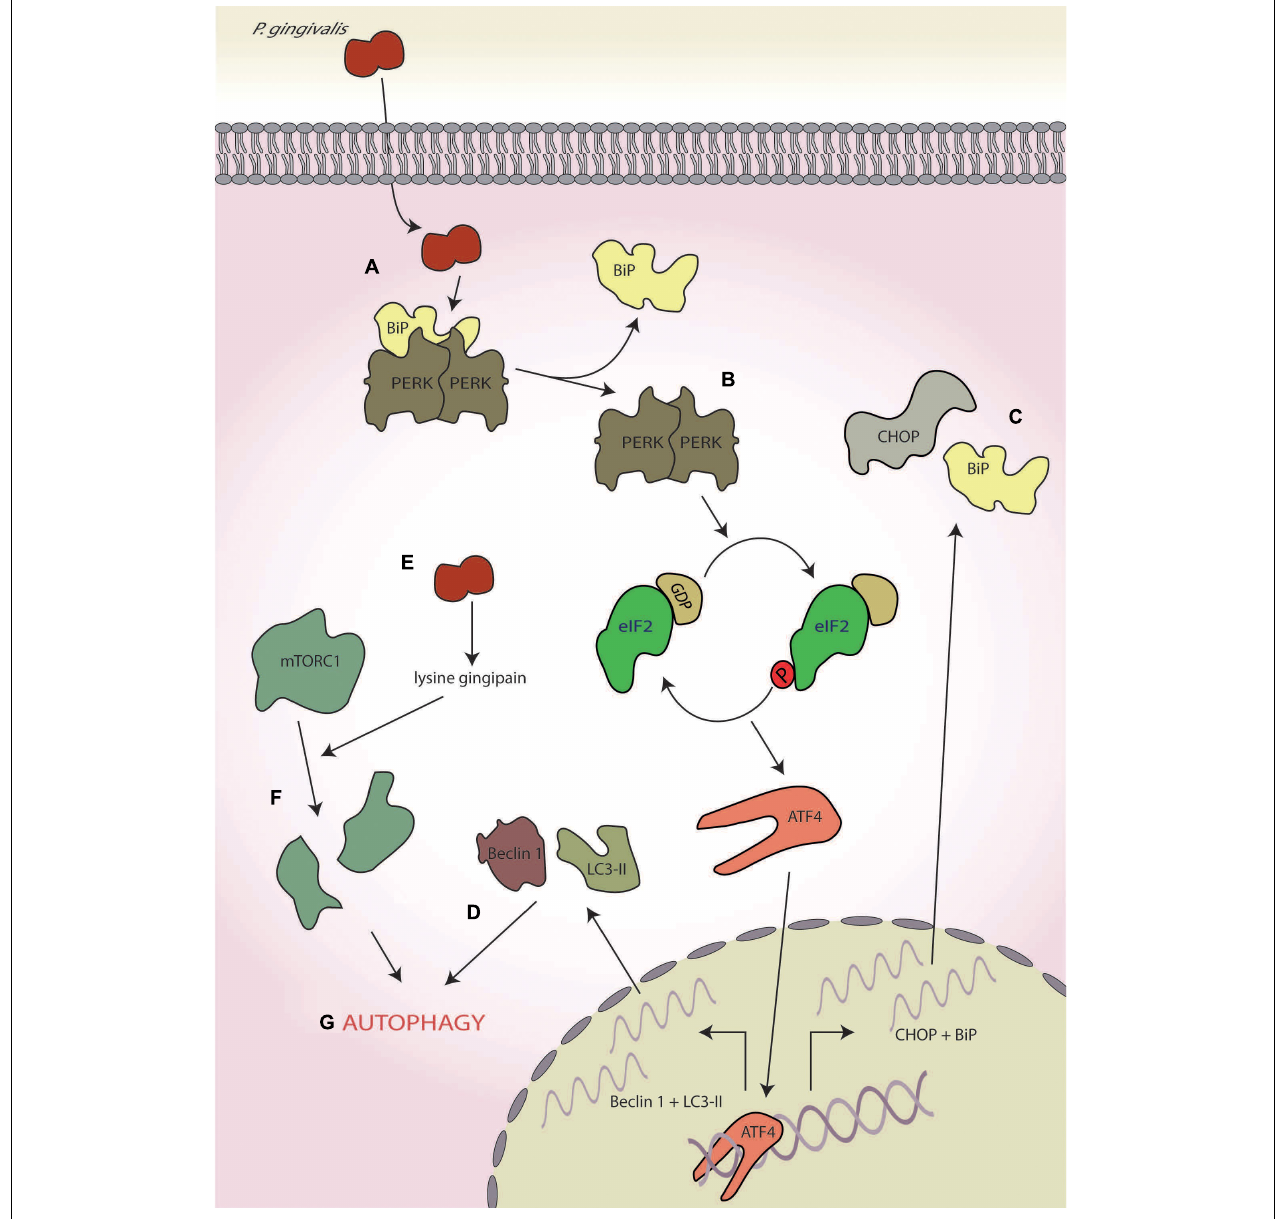
FIGURE 6 | Porphyromonas gingivalis . (A) P. gingivalis infection induces endoplasmic reticulum (ER) stress, (B) leading to protein kinase R-like ER kinase (PERK) activation, and (C) the expression of C/EBP homologous protein (CHOP) and binding immunoglobulin protein (BiP). (D) Concurrently, it also induces to autophagy as determined by the markers Beclin-1 and 1A/1B-light chain 3 (LC3-II). (E) P. gingivalis secretes a lysine-specific cysteine protease, termed the lysine gingipain, (F) which degrades mammalian target of rapamycin complex 1 (mTORC1), and (G) leading to the induction of